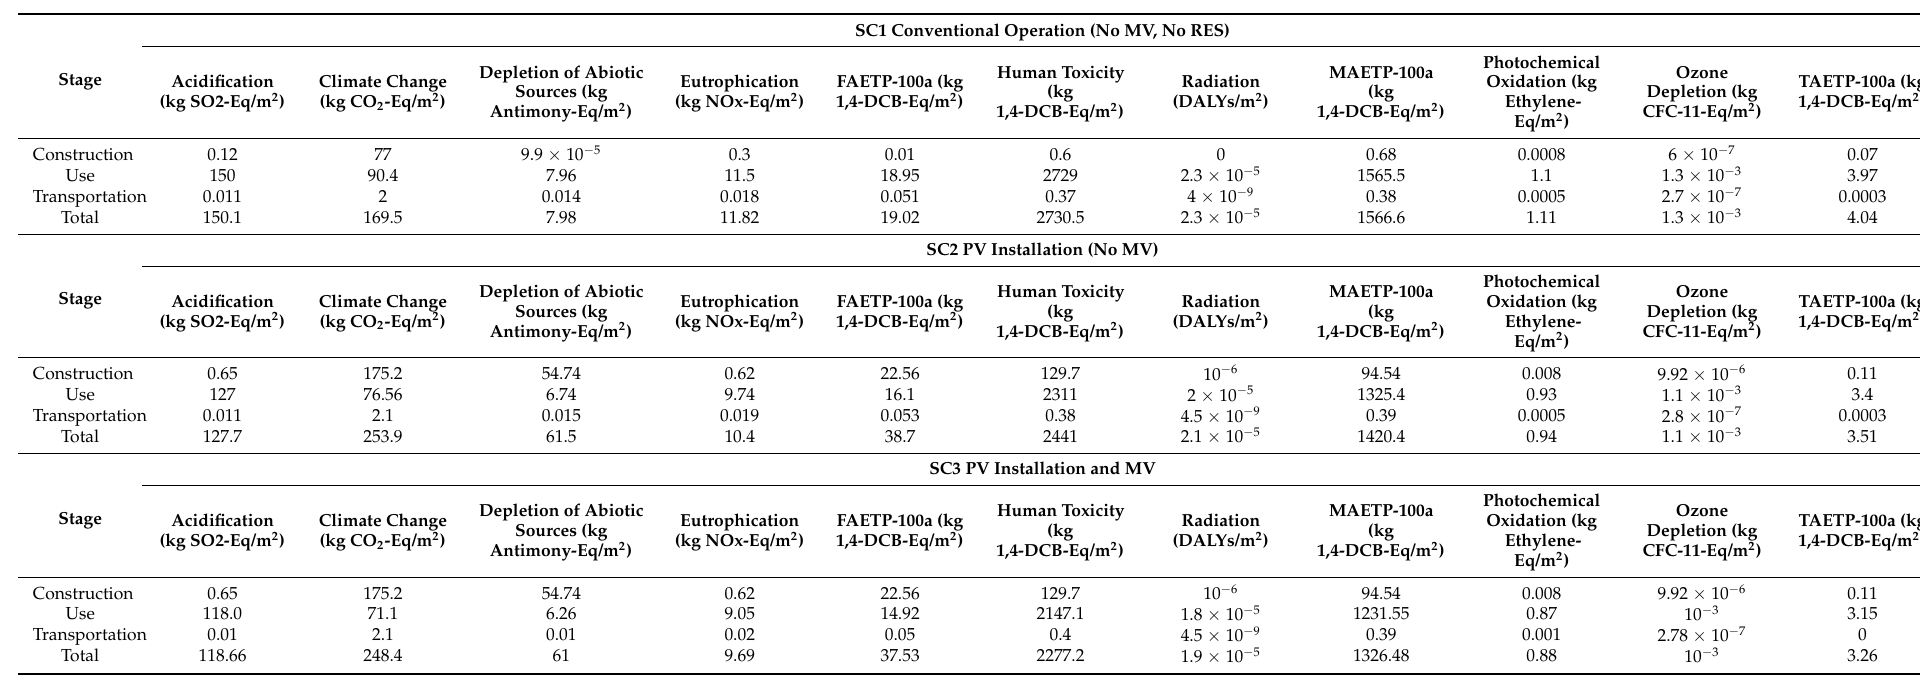
Table 5. Environmental impact assessment results for different construction scenarios and systems in non-residential buildings.